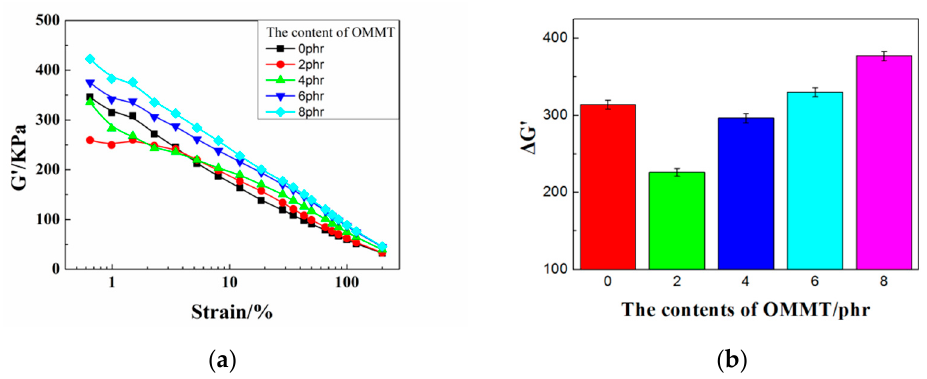
Figure 5. ( a ) G’-strain and ( b ) Δ G’ of CB/NR composites with different contents of OMMT.